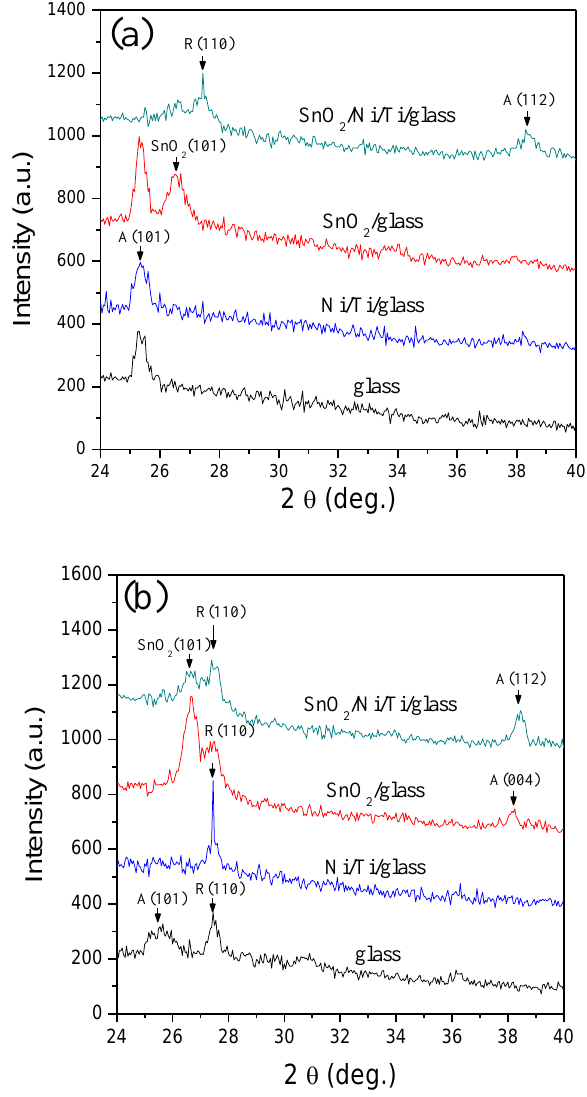
Figure 1. XRD patterns of TiO 2 films grown at ( a ) 250 ◦ C and ( b ) 350 ◦ C on various indicated underlying materials. The peak A and R indicate anatase and rutile TiO 2 , respectively.